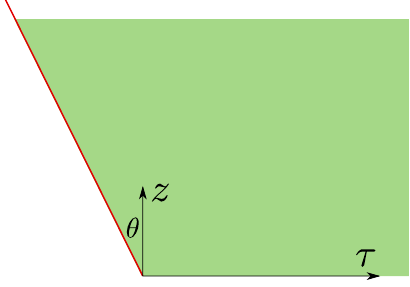
Figure 2 . The bulk (green) is bounded by the asymptotic boundary at z = 0 , and the brane (red) shooting off at an angle θ in the z − τ plane, hits the boundary at τ = 0 . Transverse directions are